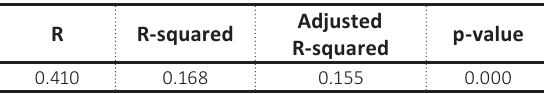
Table 14. Summary of the regression model